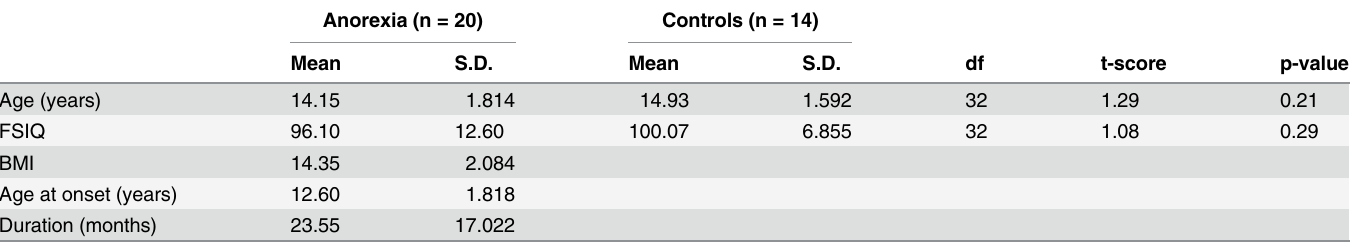
Table 1. Clinical variables assessed among anorexia and control